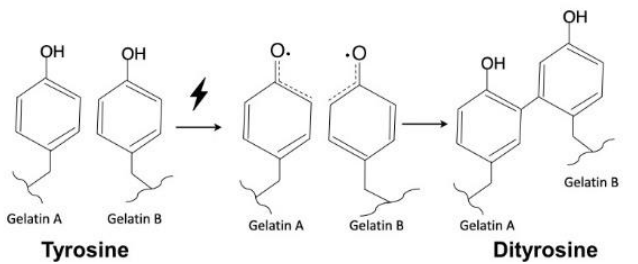
Figure 6. Schematic illustration of dityrosine bond formation.